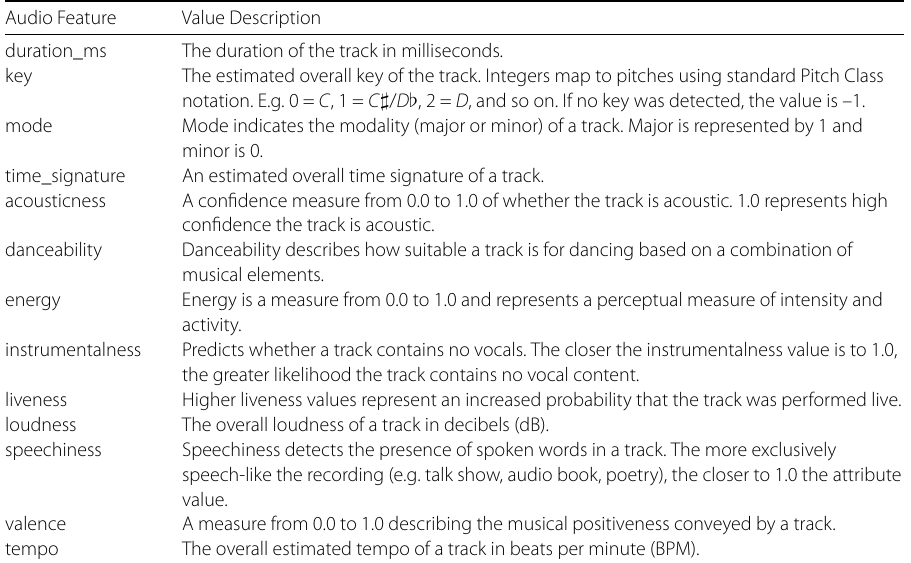
Table 5 MIR extracted audio features provided by The Echo Nest